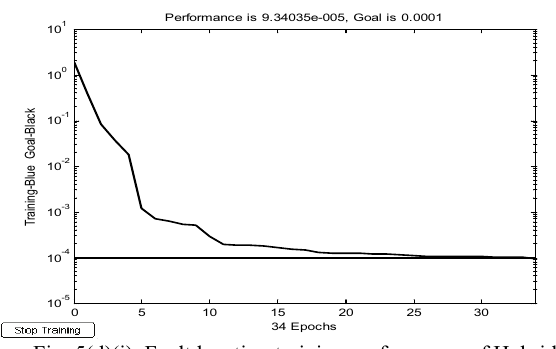
Fig. 5(c)(i). Fault location training performance of Hybrid approach for double line to ground fault (0-50Km)